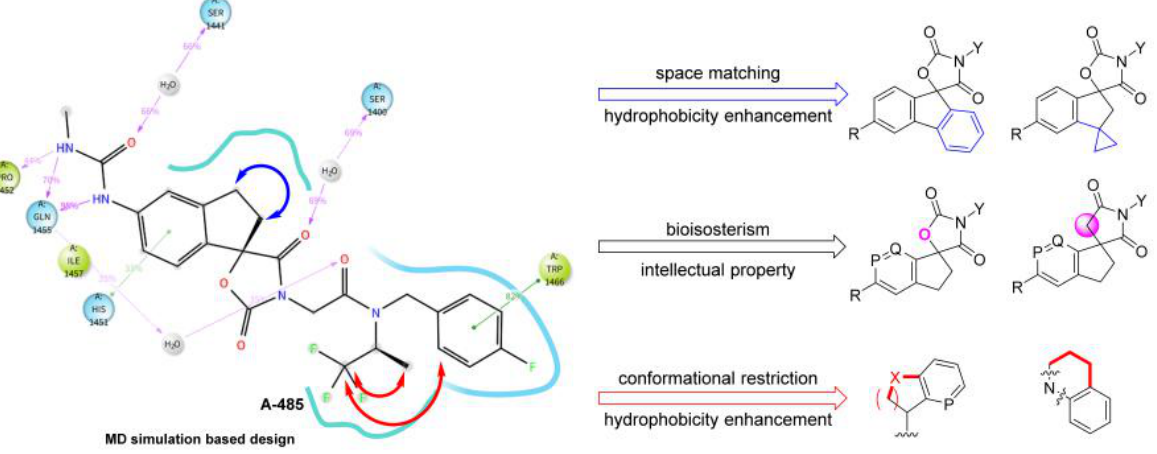
Figure 3. Current main design of new spirocyclic derivatives (P, Q = CH,